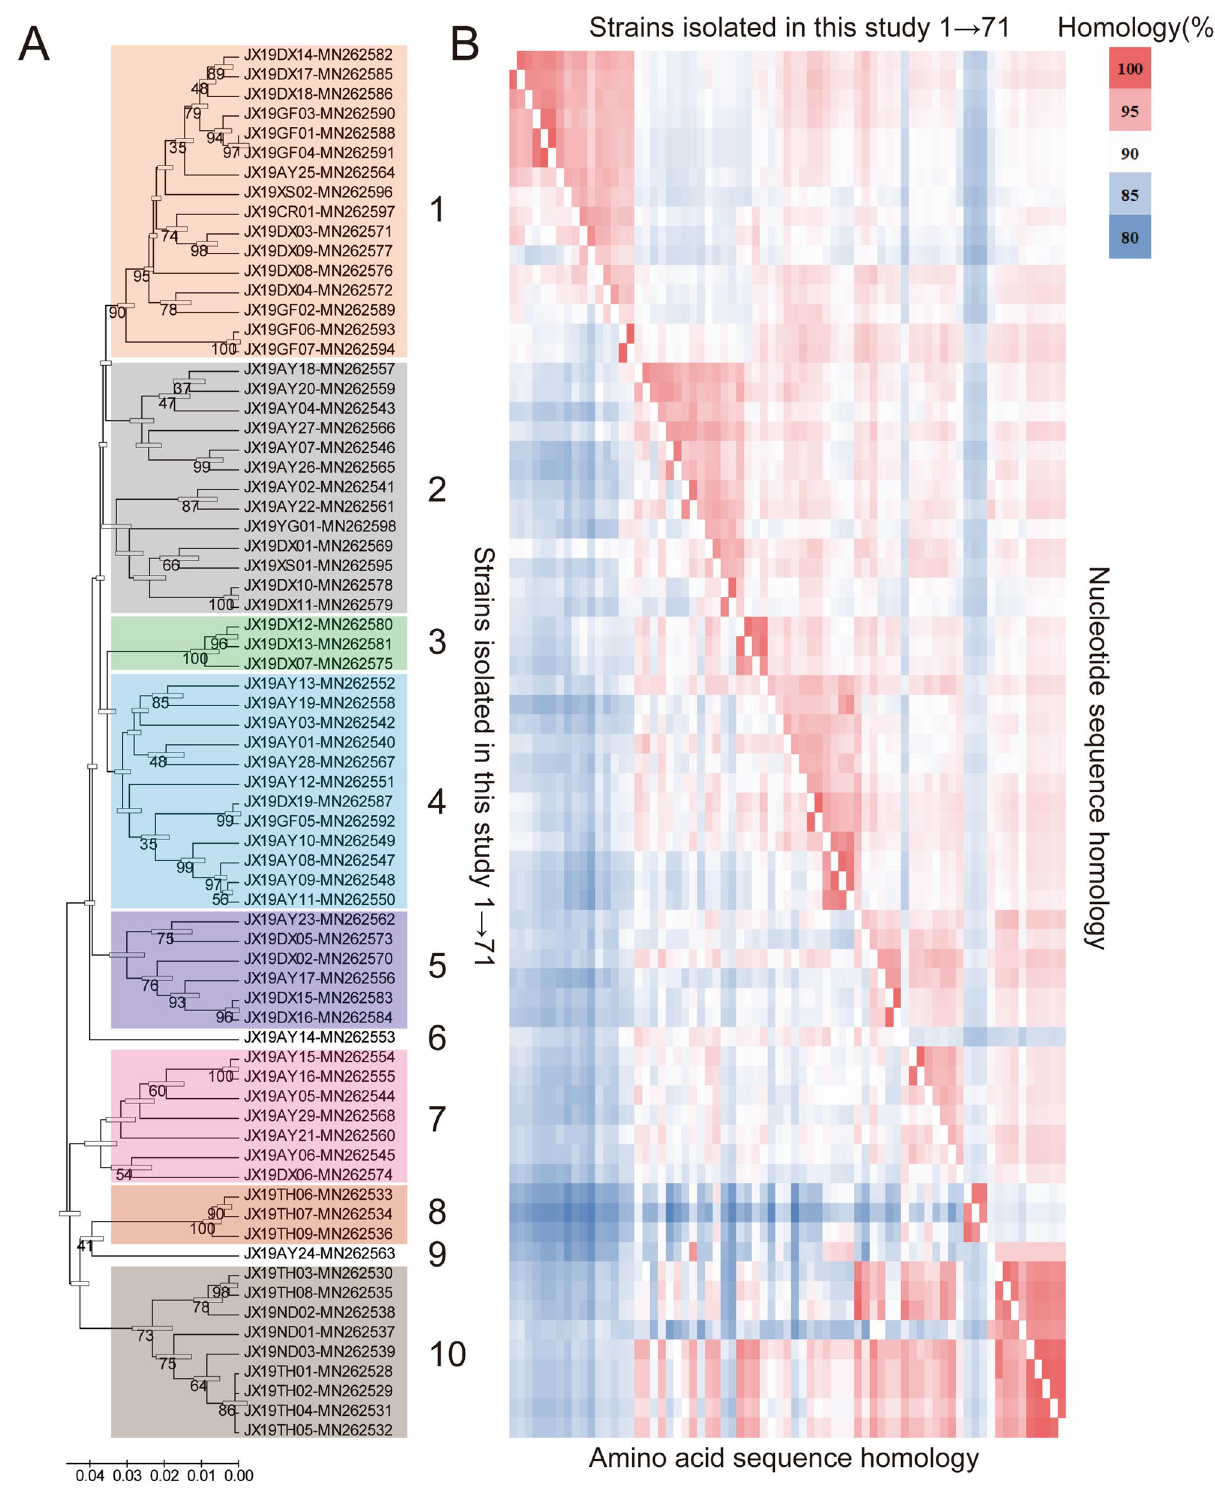
Figure 4. Sequences analysis of 71 ALV-J strains isolated in this study. ( A ) Phylogenetic analysis based on the env sequences of 71 ALV strains isolated in this study using the maximum likelihood method with 1000 bootstrap replications. The bar indicates genetic distance; strains in the same branch are labeled with the same color using Adobe Illustrator CS6; ( B ) similarity analysis heat map of 71 ALV strains isolated in this study; on both sides of the main figure is the virus strains, and in the middle is the similarity value (upper right: similarity of nucleotide sequences; lower left: similarity of amino acid sequences); different identity values are expressed in progressive colours ranging from 80 to